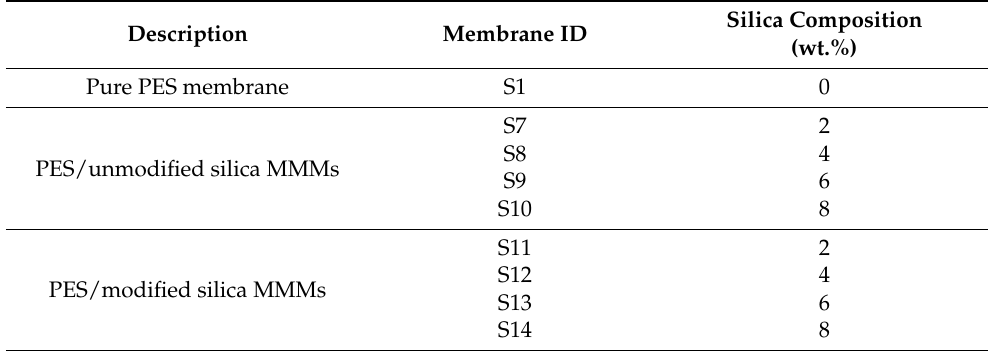
Table 1. Composition of pure PES membrane and PES/unmodified and PES/modified silica MMMs and their coding at various silica loadings. Silica Composition Description Membrane ID (wt.%) Pure PES membrane S1 0 S7 PES/unmodified silica MMMs